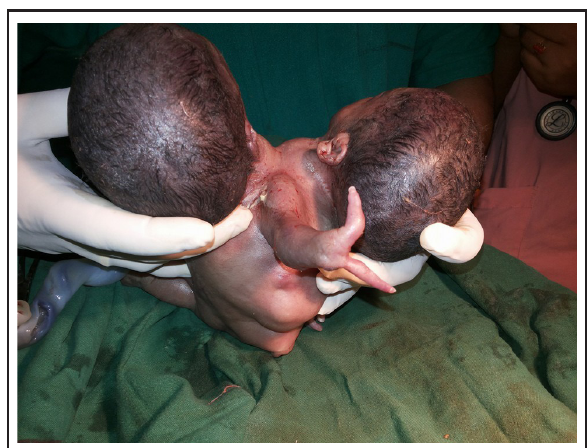
Figure 1. Conjoined Twins.